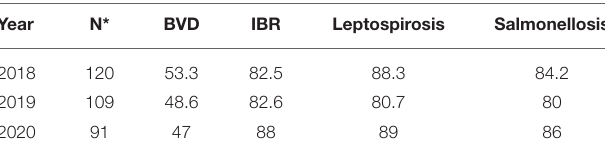
TABLE 2 | Vaccination use (% of herds) among study herds for BVD, IBR, leptospirosis, and salmonellosis. Year N* BVD IBR Leptospirosis